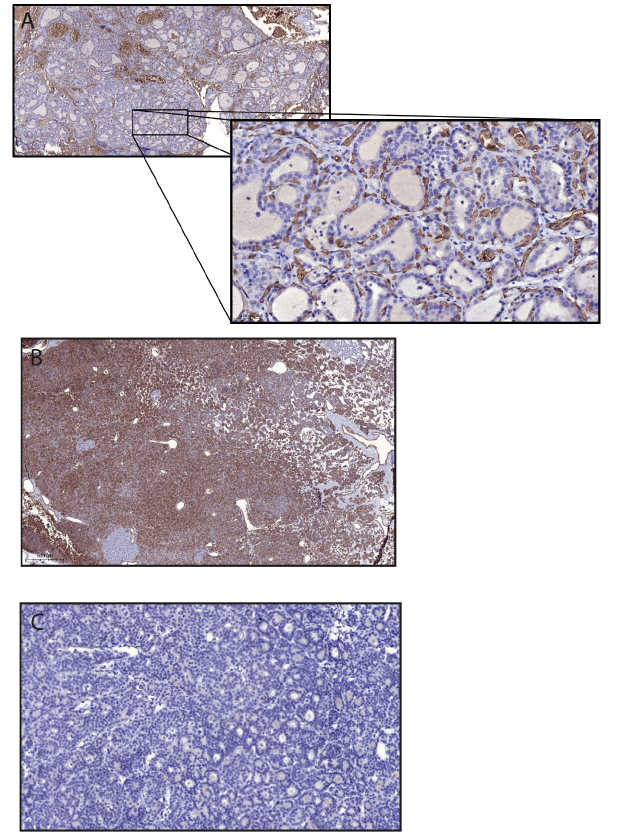
Figure 10. Immunohistochemical evaluation of blood group antigen expression in thyroid ( A ) and parathyroid ( B , C ) glands collected from patients with blood group A ( A , B ) and O ( C ). ( A ) Illustrates positive anti-blood group A antibody staining in the supportive and vascular tissue of the thyroid gland. The magnification demonstrates the expression of blood group A antigen in the c-cells. No expression of blood group A antigens was found in the follicular cells. ( B ) Illustrates the high expression of blood group A antigens in the parathyroid cells from a patient with blood group A. ( C ) Shows weak cytoplasmatic expression of H type 1 in a blood group O individual.